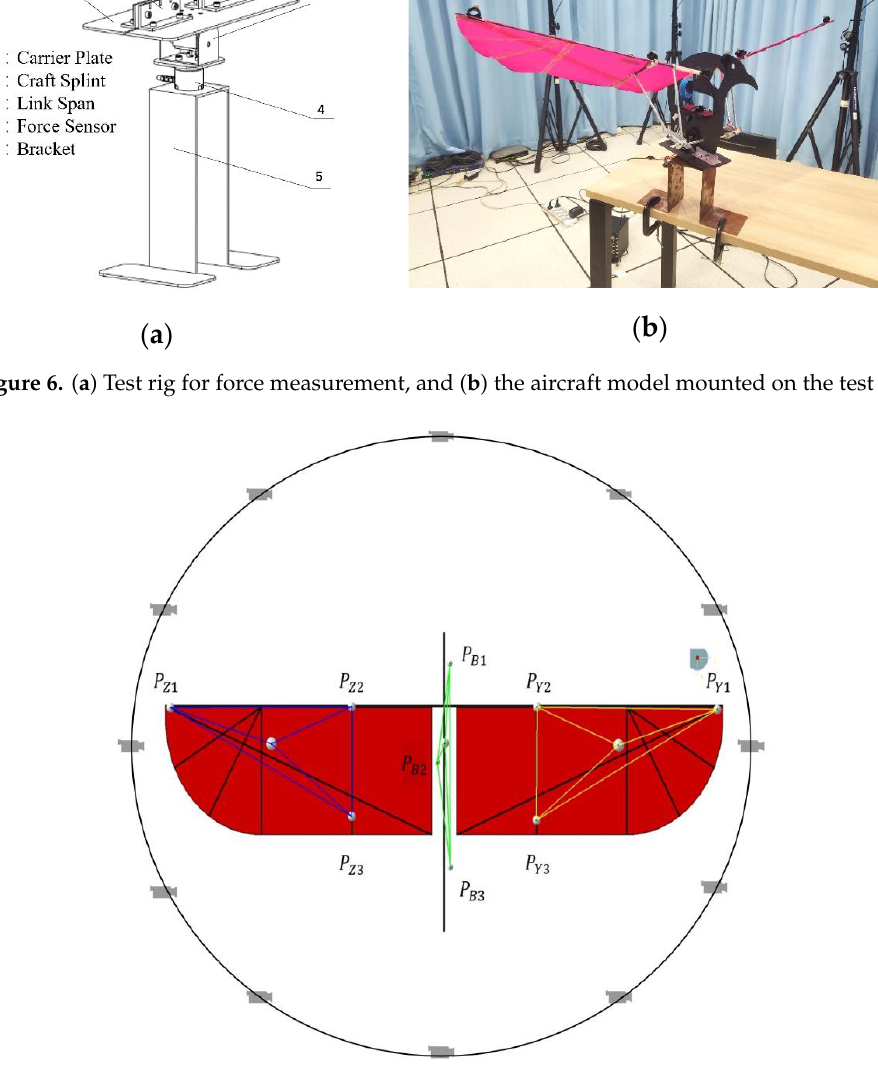
Figure 7. The OptiTrack motion capture system with 12 cameras positioned around the test model.